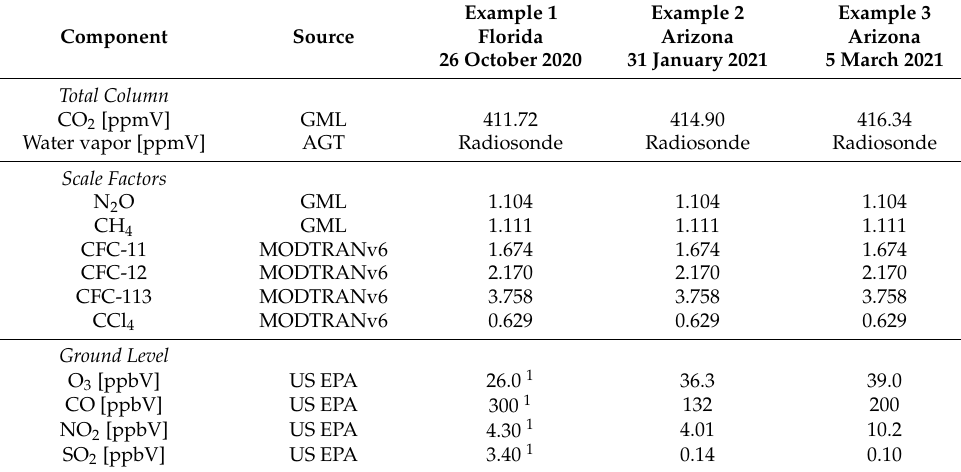
Table 2. Updated atmosphere values for MODTRAN: GML—NOAA Global Monitoring Labora- tory; AGT—Atmosphere Generator Toolkit; MODTRANv6—MODTRAN Version 6 User Manual;